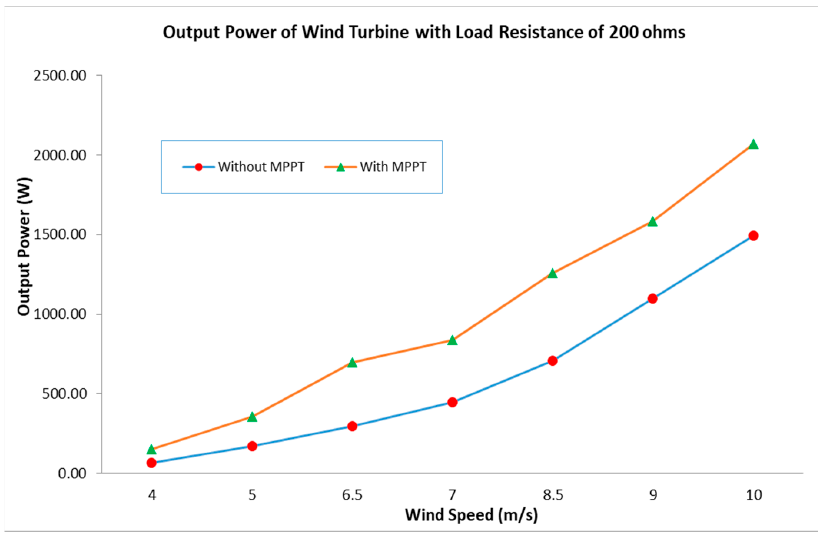
Figure 16. Output power of wind turbine system with load resistance of 200 Ω .